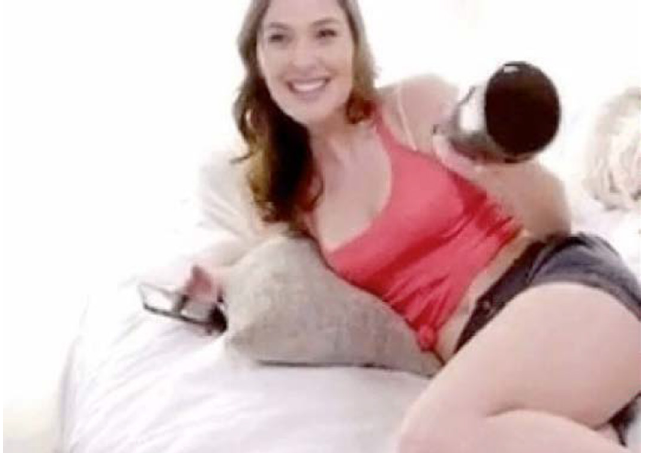
Fig. 5 A fake pictures